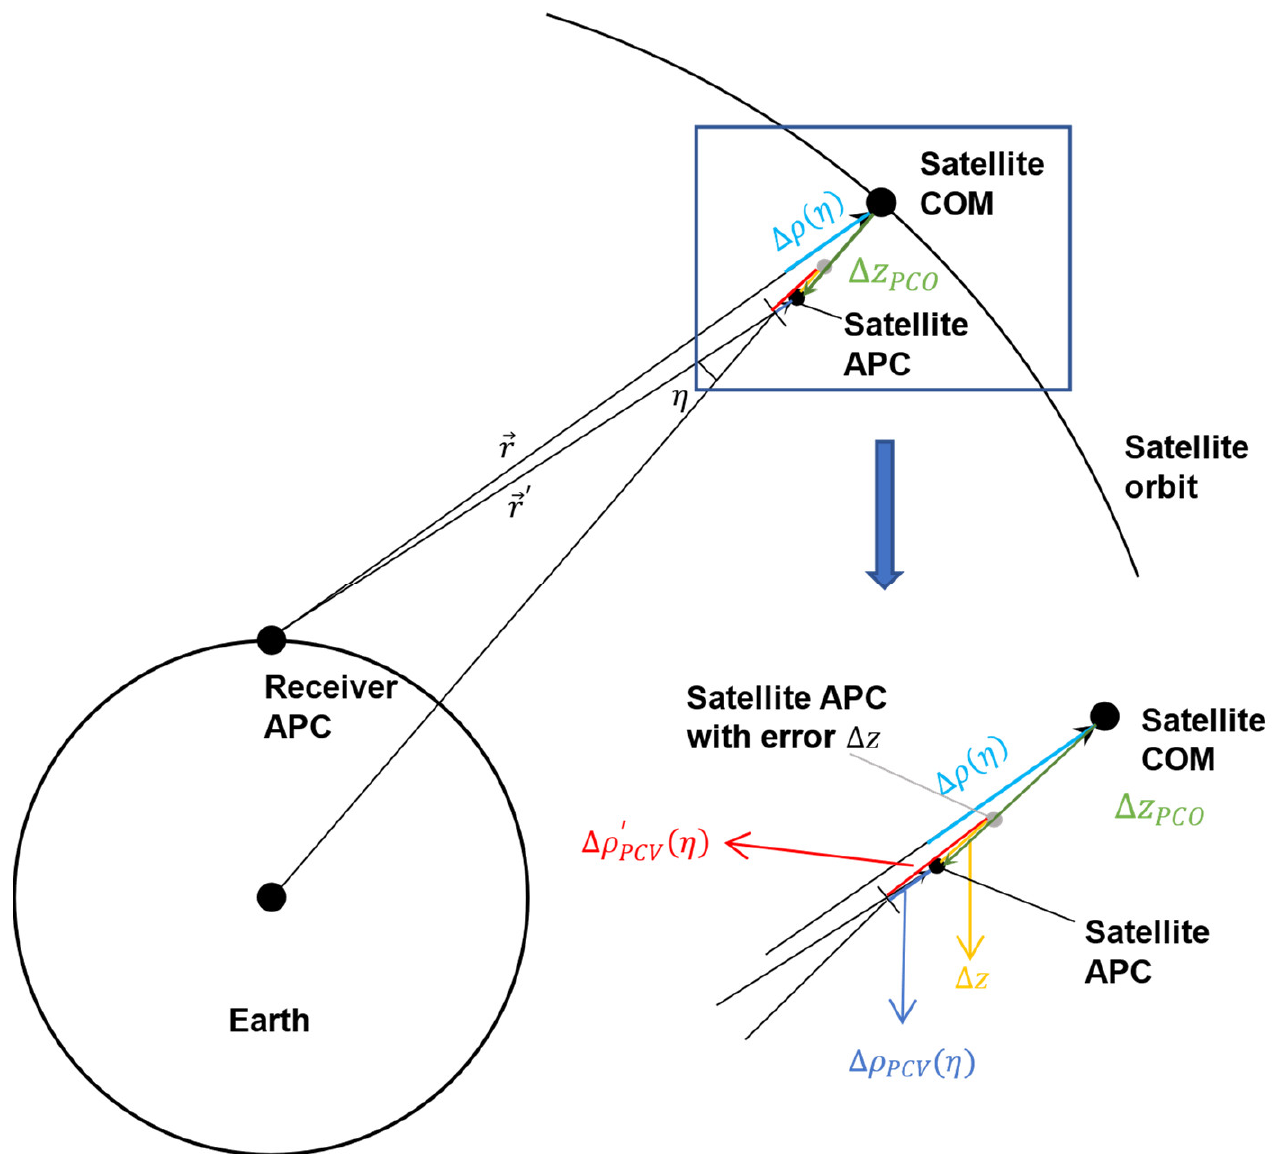
Figure 1. The geometric relation of the estimated PCC model parameters.